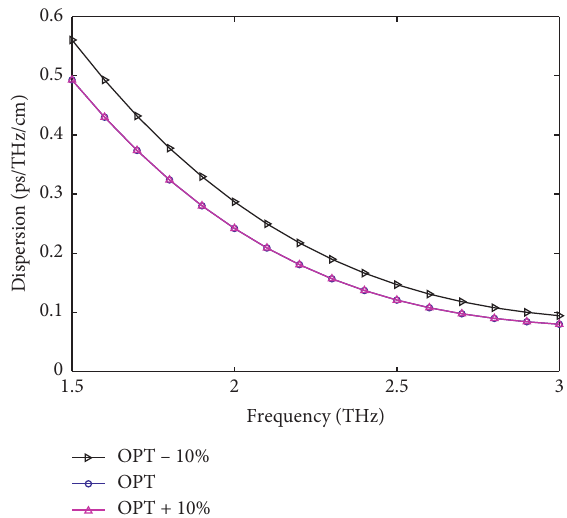
Figure 6: Representation of the dispersion for the three models in the THz